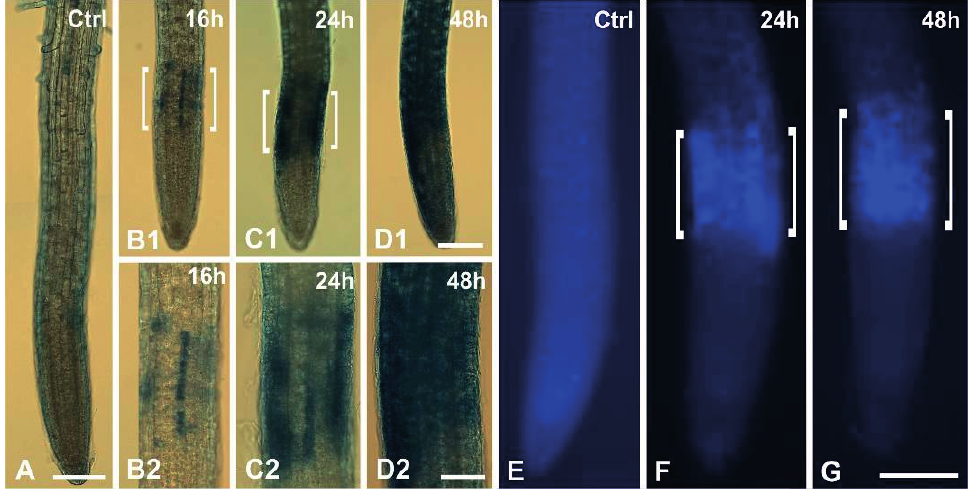
Figure 2. Detection of cell death (by Evans blue staining) and callose deposition in root tips of A. thaliana . ( A – D ) Evans blue staining of an untreated ( A ) and Cr(VI)-treated roots ( B – D ), at lower ( B1 – D1 ) and higher ( B2 – D2 ) magnifications. Note the time-dependent enhancement of staining, especially at the transition zone ( B – D , brackets); ( E – G ) Callose detection with aniline blue; ( E ) Control. No specific fluorescence is seen; ( F , G ) 24 h ( F ) and 48 h ( G ) Cr(VI) treatment. Aniline blue fluorescence is localized in the transition zone (brackets). Scale bars: ( A , B1 – D1 , E – G ): 100 μ m; ( B2 – D2 ): 50 μ